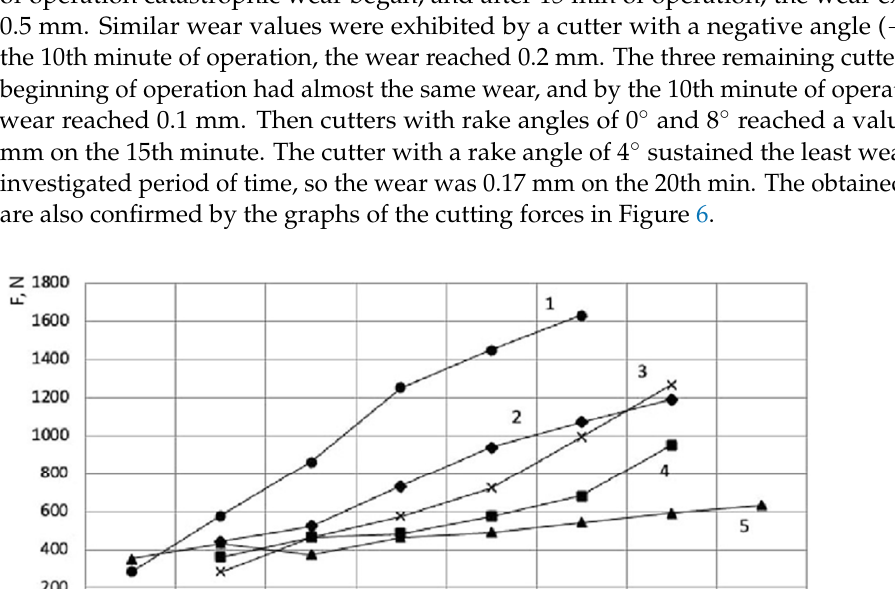
Figure 6. Graph of the dependency of flank wear land vs. the rake angle of the cutter: 1— γ = 12°; 2— γ = − 7°; 3— γ = 8°; 4— γ = 0°; 5— γ = 4°. Figure 7 shows the graph of the flank wear land of the tooth vs. the time of operation of the cutter for the cutting speeds of 50, 35, and 25 m/min (curves 1, 2, and 3, respectively). It can be seen from the graph that the cutter operating at the cutting speed of 25 m/min sustained the least wear in the investigated period of time, so on the 28th min of operation, the flank wear land reached 0.11 mm. The cutter operating at the speed of V = 50 m/min had the highest wear, so the wear value reached 0.11 mm as early as on the 14th minute.